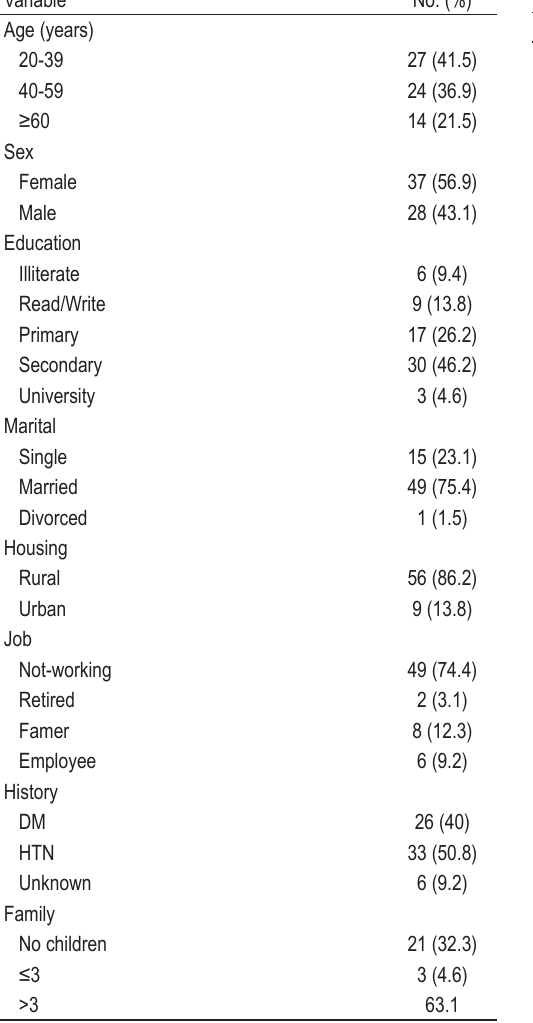
TABLE 2. Clinical characteristics of a patient undergoing maintenance hemodialysis therapy patients in the